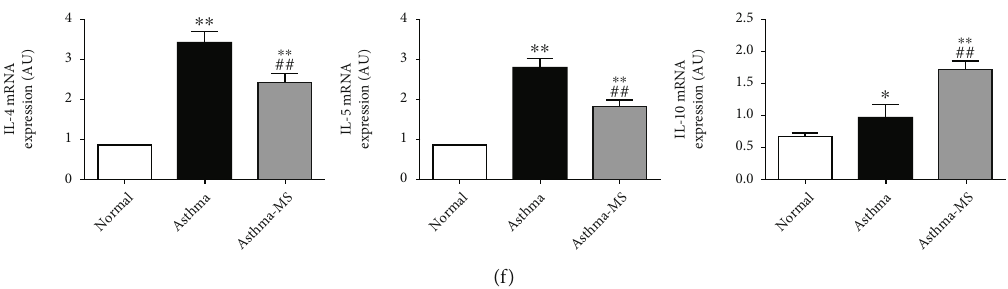
Figure 2: Methane protects mice from OVA-induced lung in fl ammation as assessed by EOS, IgE, and protein and mRNA expression of asthma-related cytokines. The representative fl ow cytometry plot indicates the EOS cell percentage in BALF (a) and these data were visualized (b). IBALF IgE (c) and IL-4 (d) levels, as well as serum IL-5 and IL-10 concentrations, were measured and analyzed by ELISA (e). In the transcriptional analysis, mRNA levels of IL-4, IL-5, and IL-10 in the lungs were evaluated and analyzed by quantitative reverse transcription PCR (f). The data are presented in the form of the mean ± SEM ( n = 6 per group). ∗ and ∗∗ denote P < 0 : 05 and P < 0 : 01 , respectively, versus control group; ## denote P < 0 : 01 , respectively, versus asthma